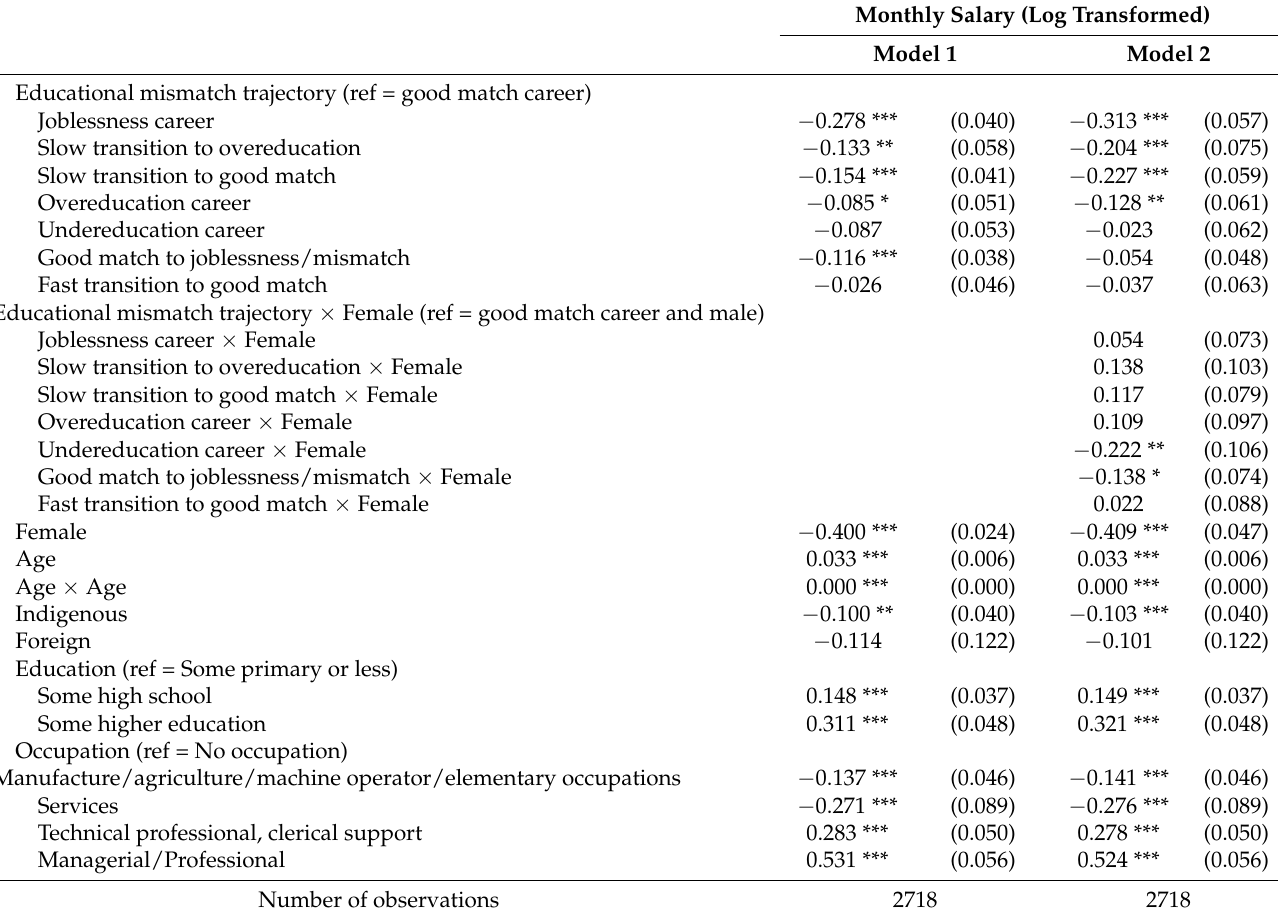
Table 2. Estimation of the effect of educational mismatch career trajectories on monthly